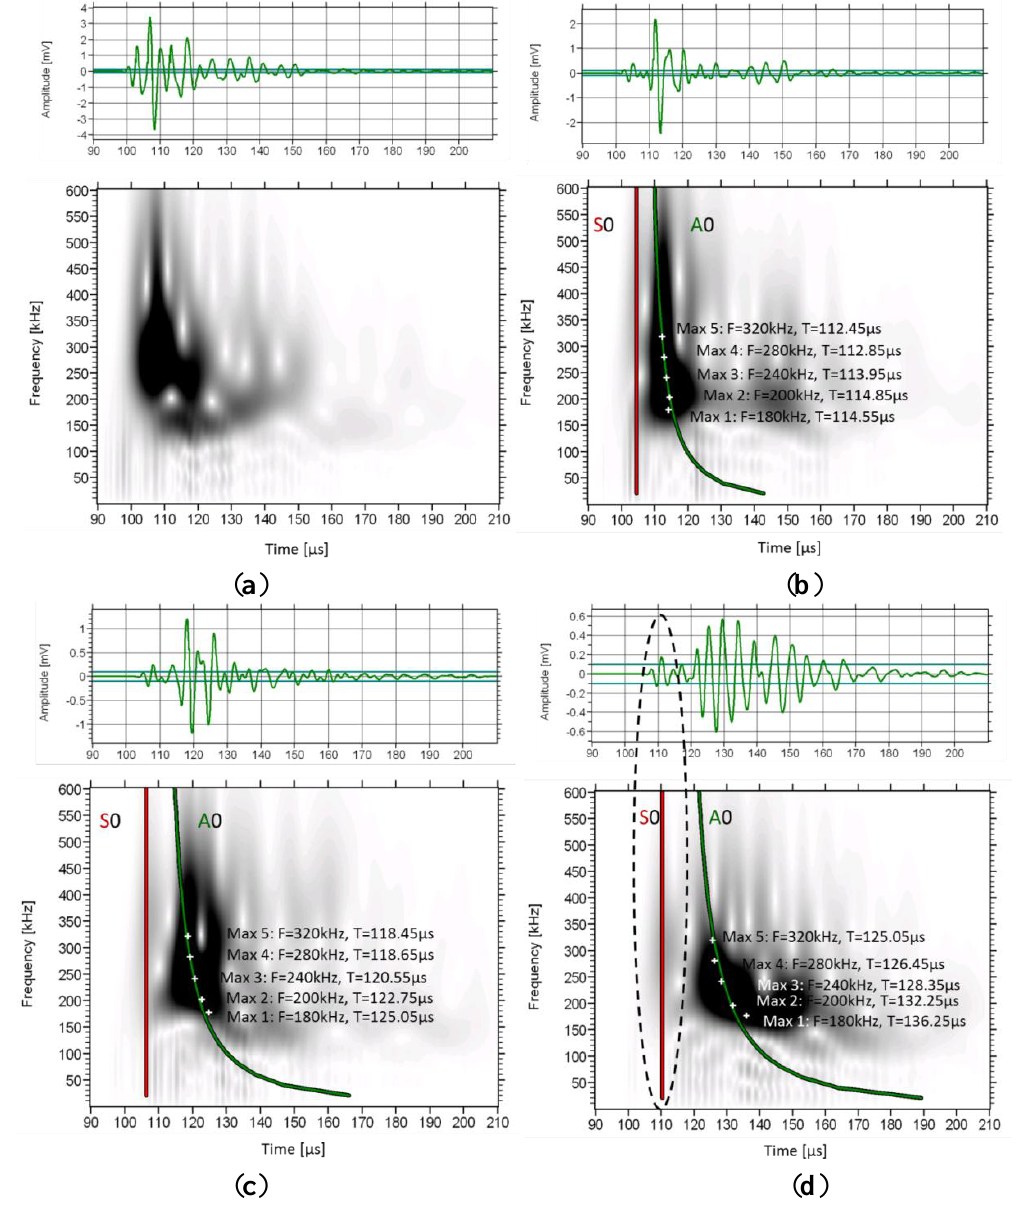
Figure 7. Waveforms and its wavelet transformation for ( a ) 1st sensor, ( b ) 2nd sensor, ( c ) 3rd sensor and ( d ) 4th sensor. The average thickness of cortical bone is 6.25